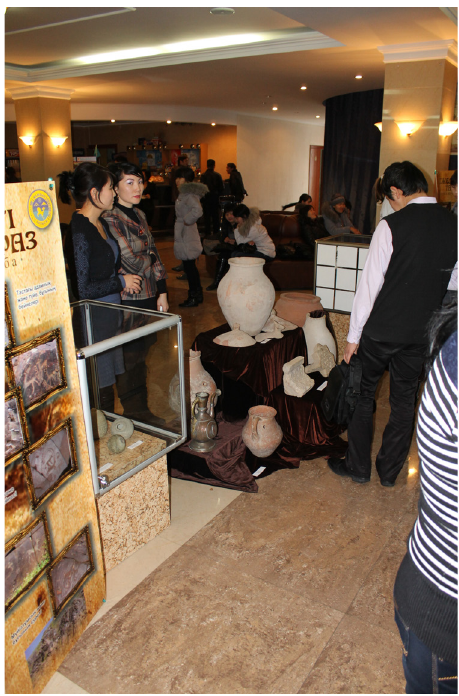
Fig. 3: Public outreach is an important part of the Taraz project and the site has attract- ed a great deal of media interest both in Kazakhstan and further